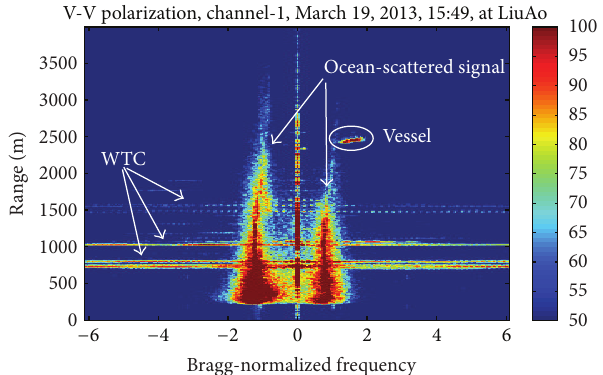
Figure 6: Range-Doppler spectrum of UHF radar.